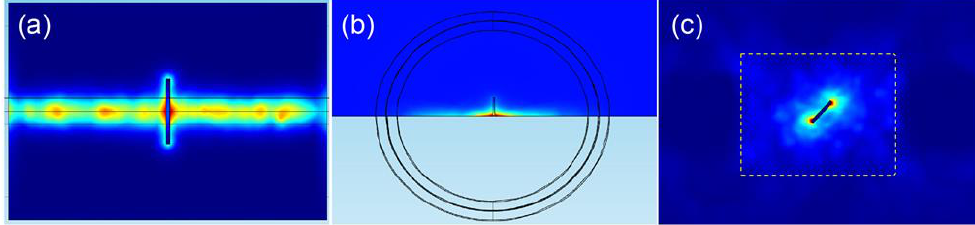
Figure 6. Simulation results of ECPT with different configurations. ( a ) Line-coil ECPT for the crack, ( b ) Helmholtz-coil-based ECPT for the crack edge. ( c ) Ferrite-yoke-based ECPT for the angular crack.